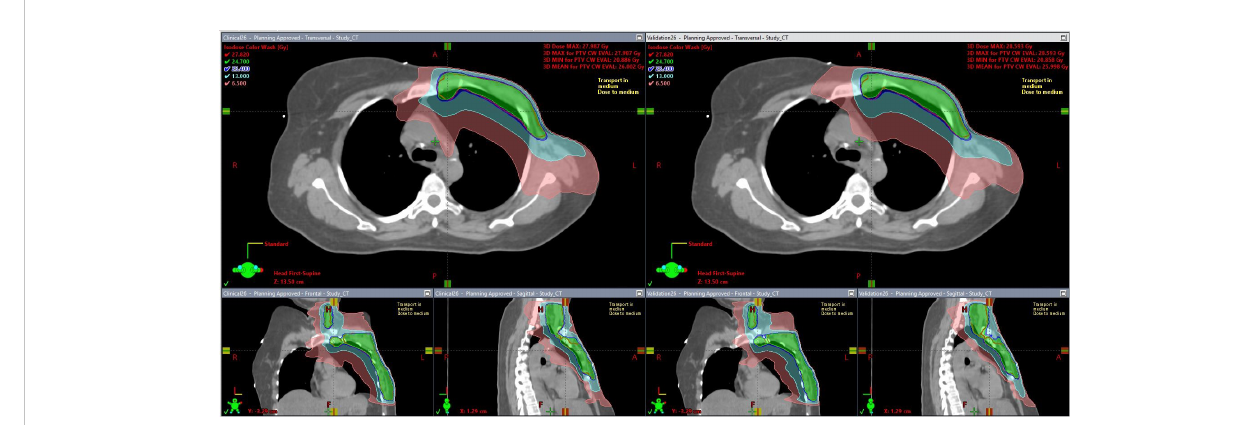
FIGURE 1 Representative dose distribution for comparison of CLI vs KBP_26Gy in 5